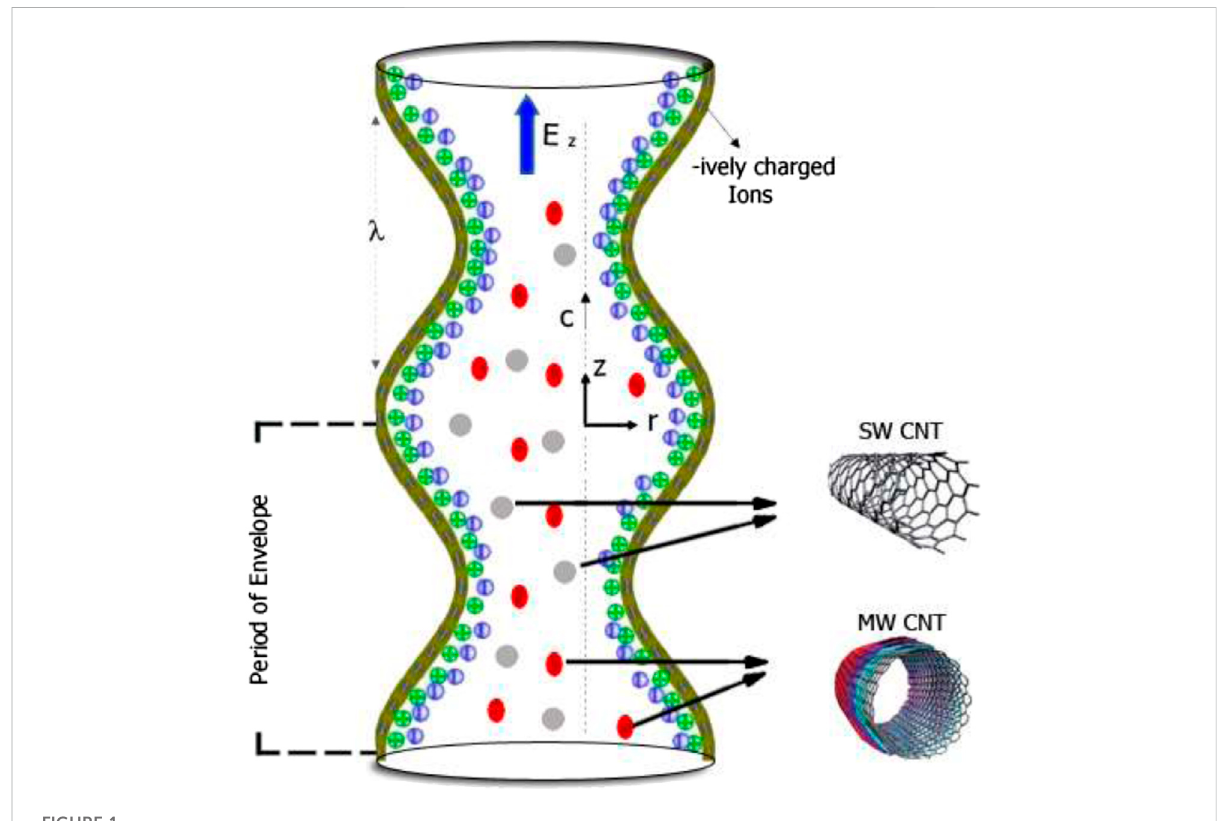
FIGURE 1 Geometry of the